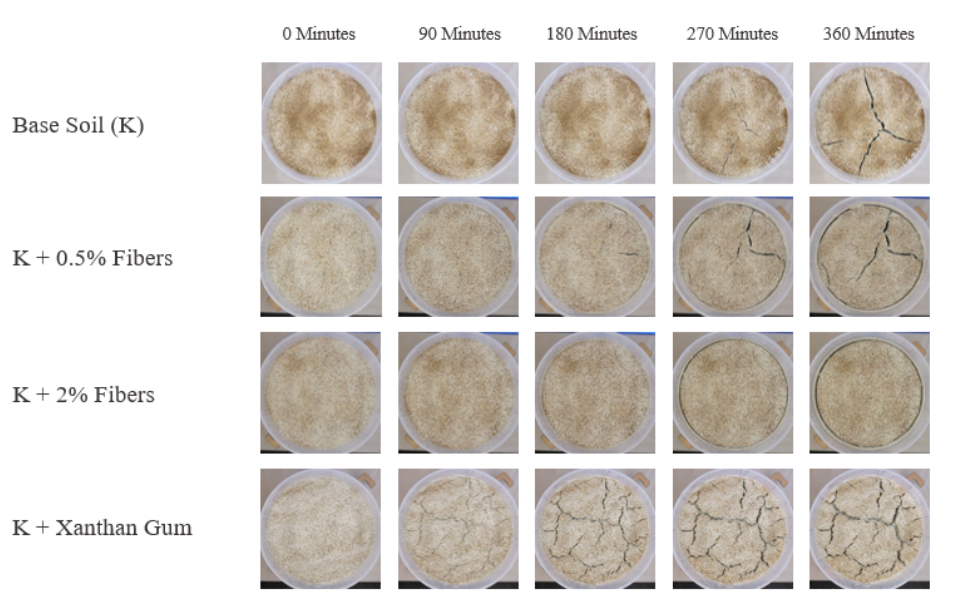
Figure 4. Desiccation test results during the six hours of drying.